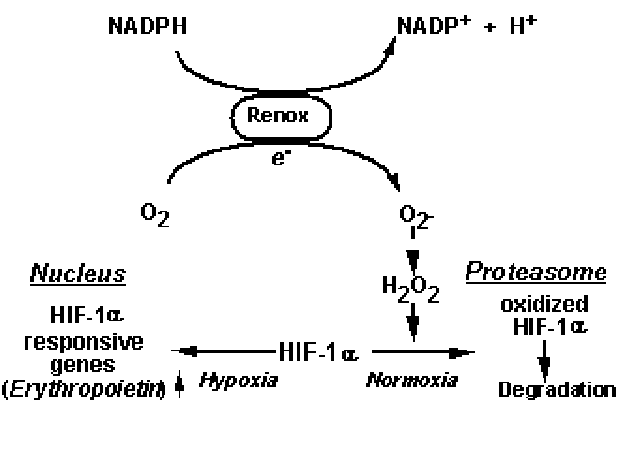
Fig. 1. Proposed scheme for down-regulation of erythropoietin production by Renox-generated